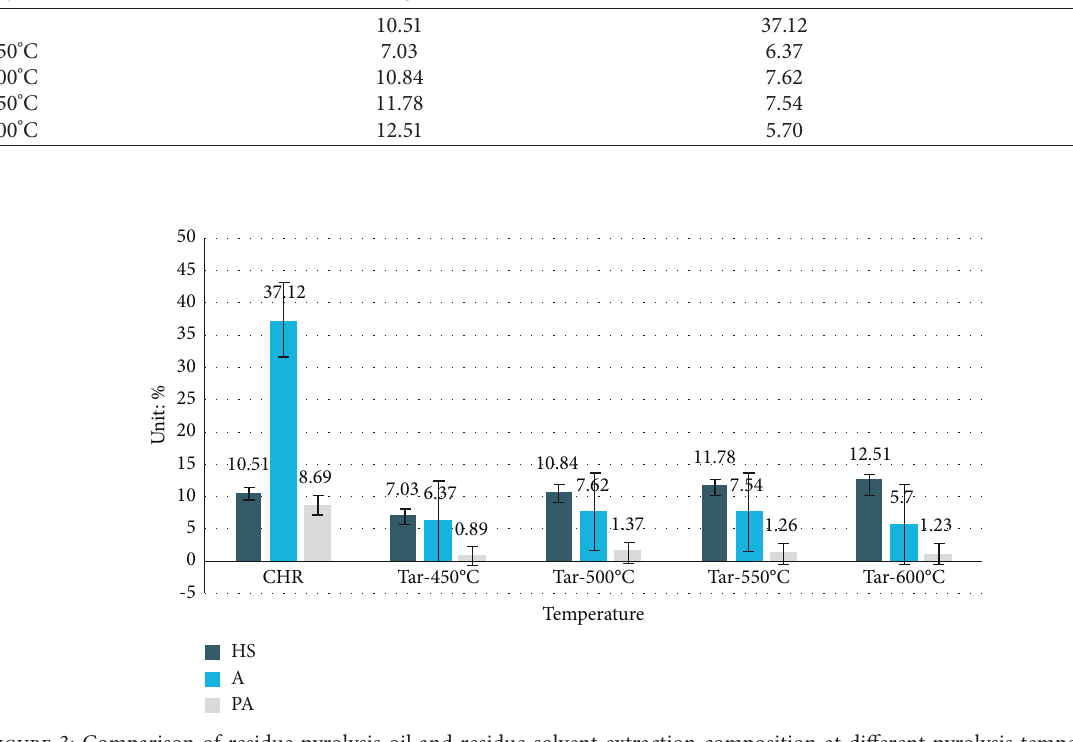
Figure 2: Solvent extraction results of residual pyrolysis oil at different pyrolysis temperatures. Table 3: Comparison of residue pyrolysis oil and residue solvent extraction composition at different pyrolysis temperatures. Sample